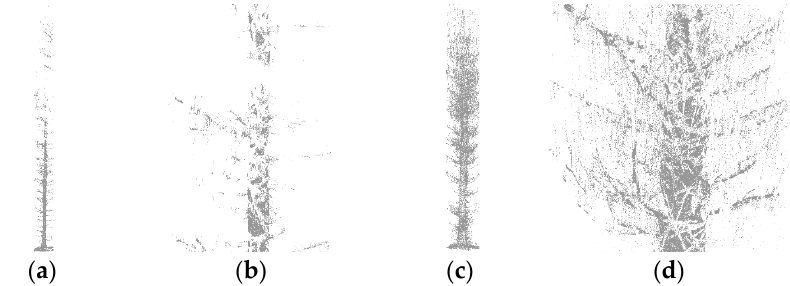
Figure 3. Examples of point clouds acquired with a terrestrial LiDAR at the Bas Saint-Laurent test sites, mainly composed of white spruce. The point clouds exhibit significant occluded areas and noise on the stem. ( a ) Isolated tree; ( b ) Close-up view of branches; ( c ) Isolated tree; ( d ) Close-up view of branches.